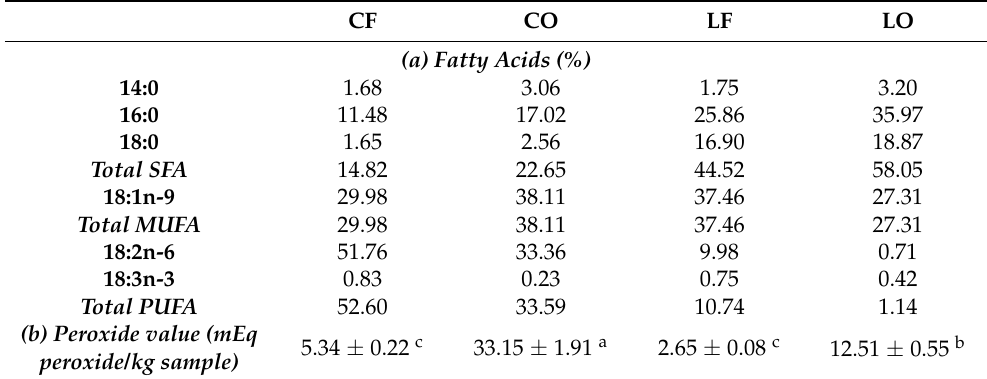
Table 2. Fatty acid composition and peroxide values of fresh corn oil (CF), oxidized corn oil (CO), fresh lard (LF), and oxidized lard (CO). CF